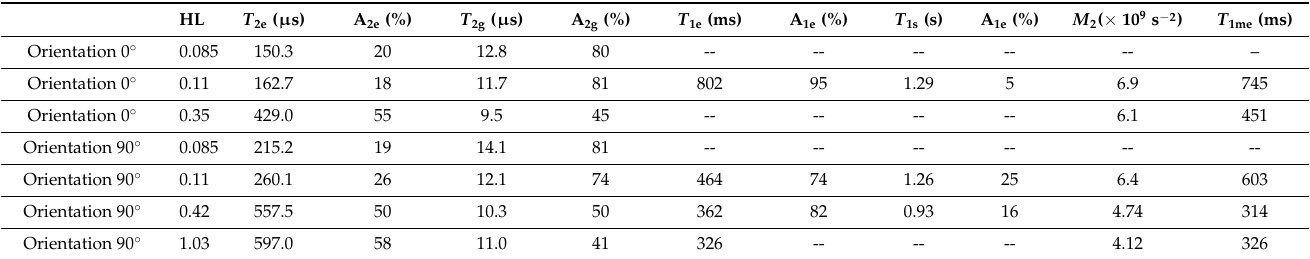
Table 3. T 2 and T 1 data on the silk fibres’ B. mori samples with parallel and perpendicular orientations to B 0 at different HL = 0.085; 0.11; 0.35; 0.42; 1.03. The result with mono-exponential fitting is marked as T 1me